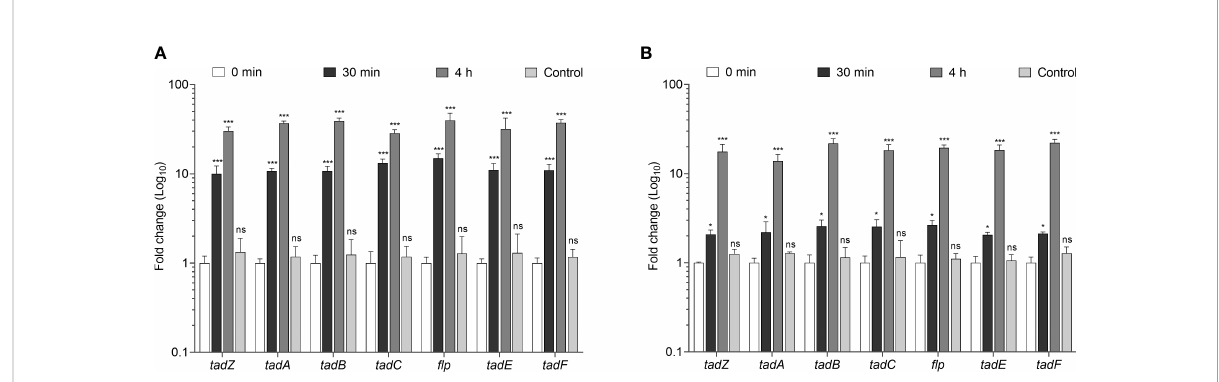
FIGURE 4 Transcriptional expression of Mtb tad/ fl p genes upon interaction with macrophages and human alveolar epithelial cells. (A) The human macrophage cell line U-937 and (B) human alveolar epithelial basal cell line A549 were infected with Mtb H37Rv for 0 min, 30 min, and 4h. As control, RPMI-1640 medium alone was used for incubation of Mtb at 37°C for 4h. Data are the mean of three different assays accomplished in triplicate with SD values. Normalization of expression was conducted by using 16S rRNA gene ( rrs ). Statistically signi fi cant relative to time zero: *** p <0.001, * p <0.05, ns, not signi fi